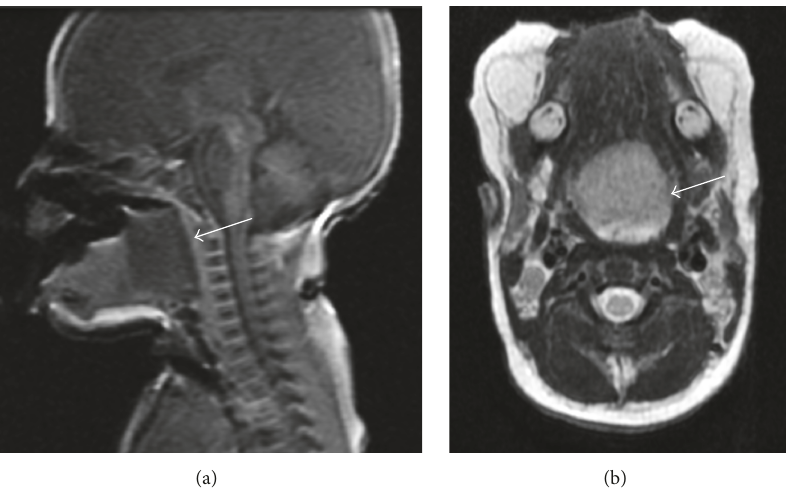
Figure 1: MRI findings of the mass on the tongue base. MRI shows a well-circumscribed mass measuring 25 × 23 × 27 mm in size in the midline region of the tongue base with a low signal intensity on T1-weighted images (a) and a high signal intensity on T2-weighted images (b).